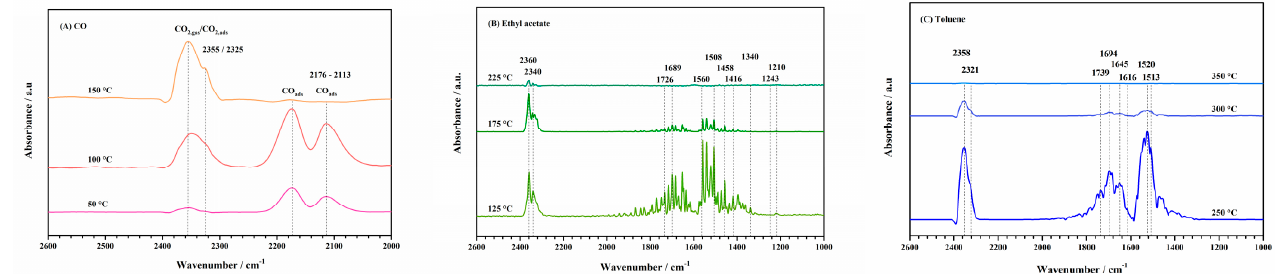
Figure 10. In situ DRIFTS spectra of the 15Cu/OMS-2 sample after 1 h of ( A ) CO oxidation at 30, 70, and 100 °C; ( B ) ethyl acetate oxidation at 125, 175, 225 °C; and ( C ) toluene oxidation at 250, 300, and 350 °C.